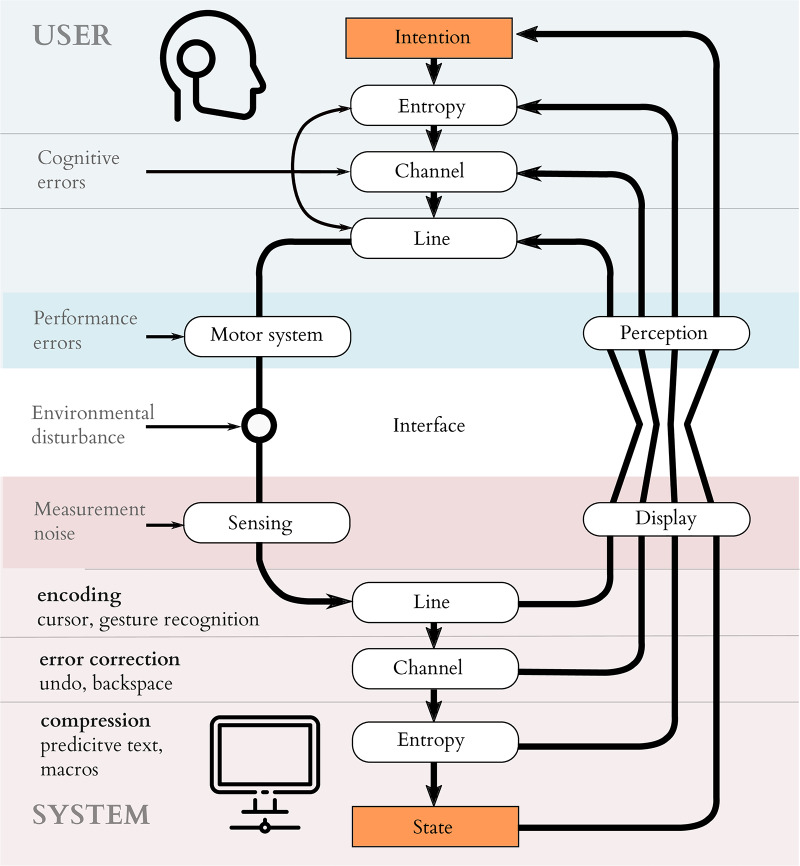
Entropy, channel and line coding in the user interface.The input problem in an asymmetric user interface, viewing the interface communication channel. The diagram shows how the feedback loop allows users to drive the internal state of a system towards their intention, via a nested series of entropy, channel and line coding steps. Sophisticated transport of information across an interface can be implemented by pushing the complexity of the encoding process from the user into the system and relying on feedback to mediate the process.